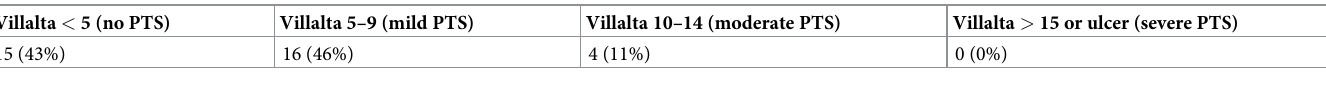
Table 3. Villalta score.